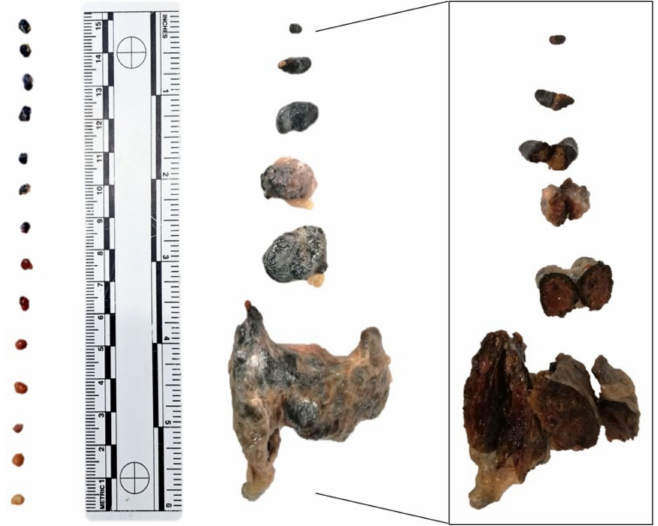
Figure 3. Size and color of the parasitic structures. Circular to oval, occasionally with a narrowed end, yellow to tan, larvae-filled cysts ( left ) and irregular, dark brown to black, firm to hard nodules ( center ) with a lighter gritty core at the cut surface ( right ).